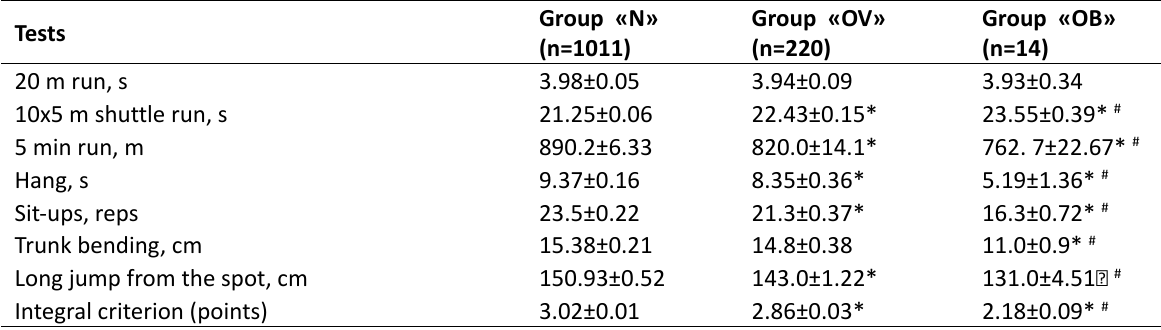
Table 2. the results of motor tests of females with different means of BMI (M±SD)